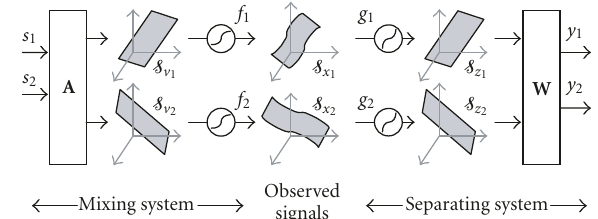
Figure 1: The post nonlinear (PNL) mixing-separating system. Figure 2: Geometric description of a PNL mixing and separating system in a 3D